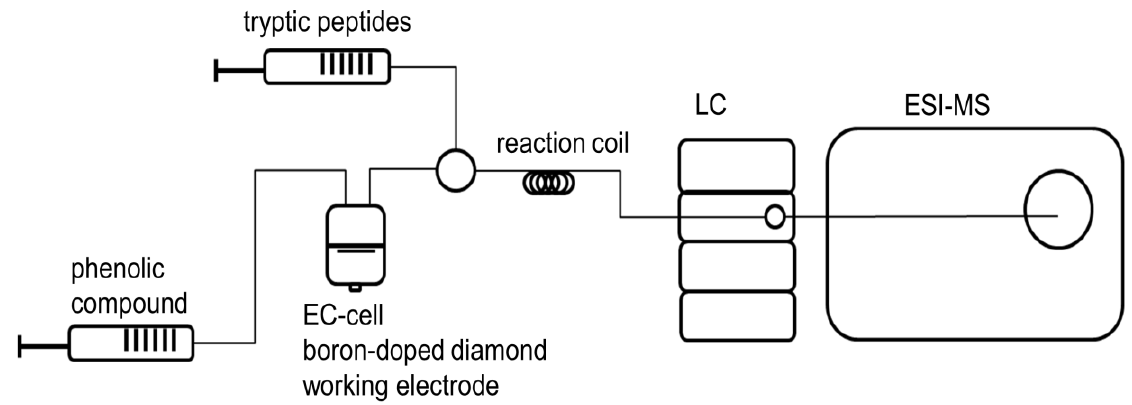
Figure 6. EC/LC/ESI-MS instrumental setup for oxidation, reaction, and separation of potentially phenol-protein-adducts. Phenolic acids are oxidized electrochemically via a thin-layer cell including a boron-doped diamond working electrode. A second flow system consists of a solution of tryptic peptides. Both solutions were combined using a three-way valve and a reaction coil and afterwards infused into the LC/ESI-MS system.